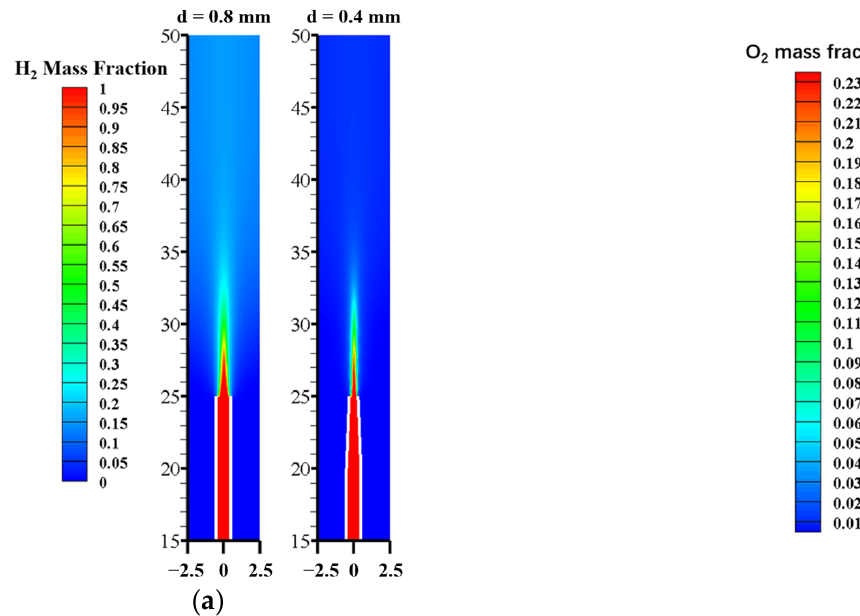
Commented [M3]: 1.Please add space before and after “=” sign. 2.Please add space between number and unit in the figure. 3.Please change hyphen to minus in the figure. Answer: I have checked and revised all.